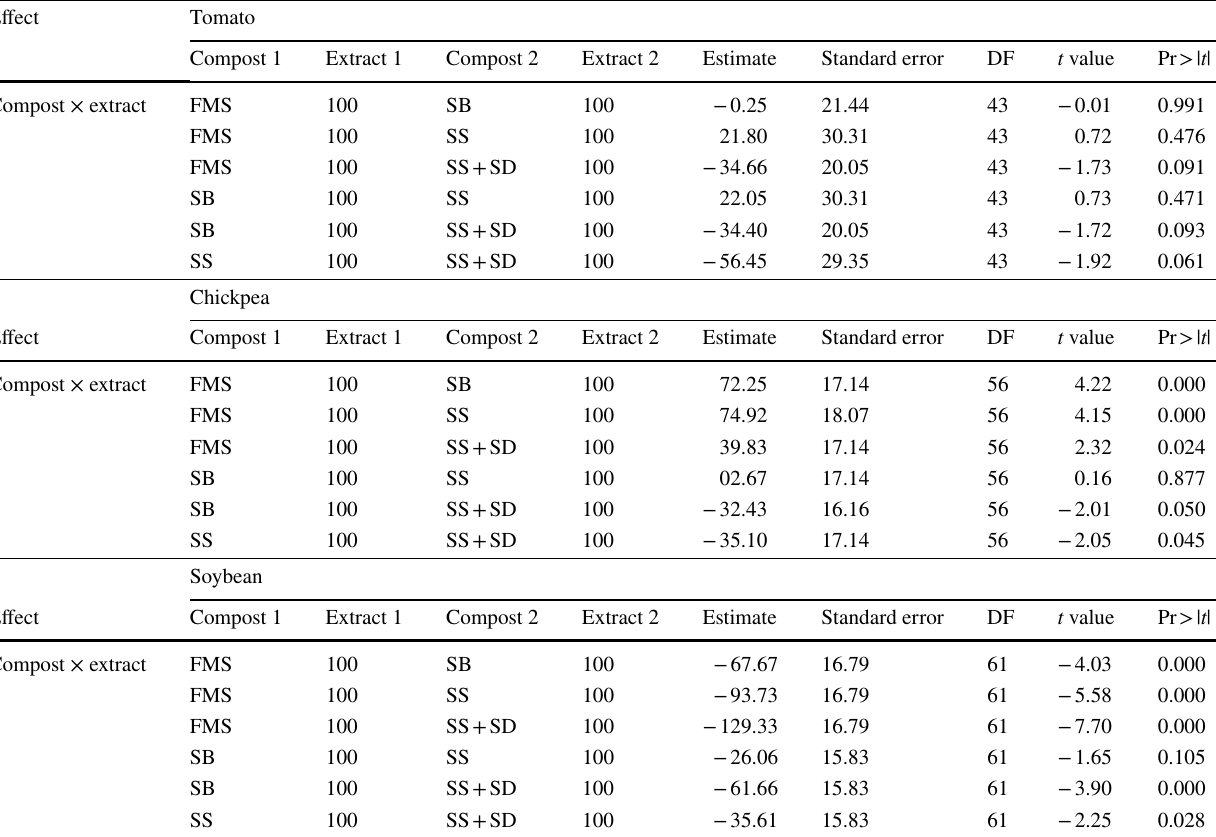
Table 5 Multiple comparisons of composts from the four agricultural straw residues